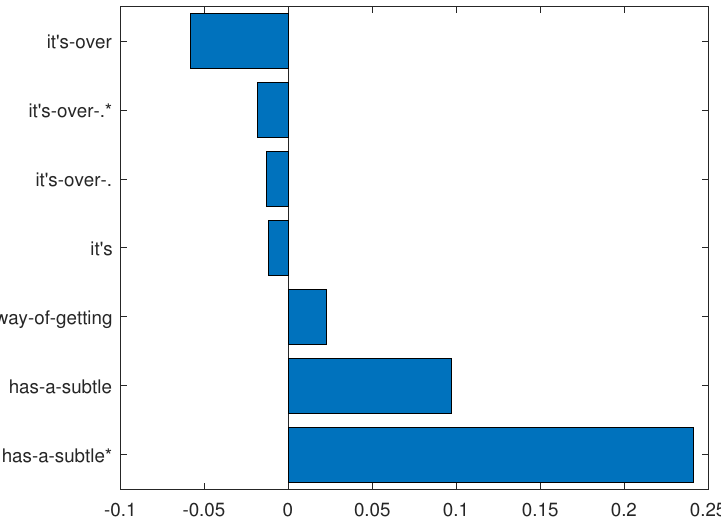
Figure 11. N-grams determined from R 24 and the following “tweet”: “it has a subtle way of getting under your skin and sticking with you long after it’s over”. The sum of the n-grams linear contributions is